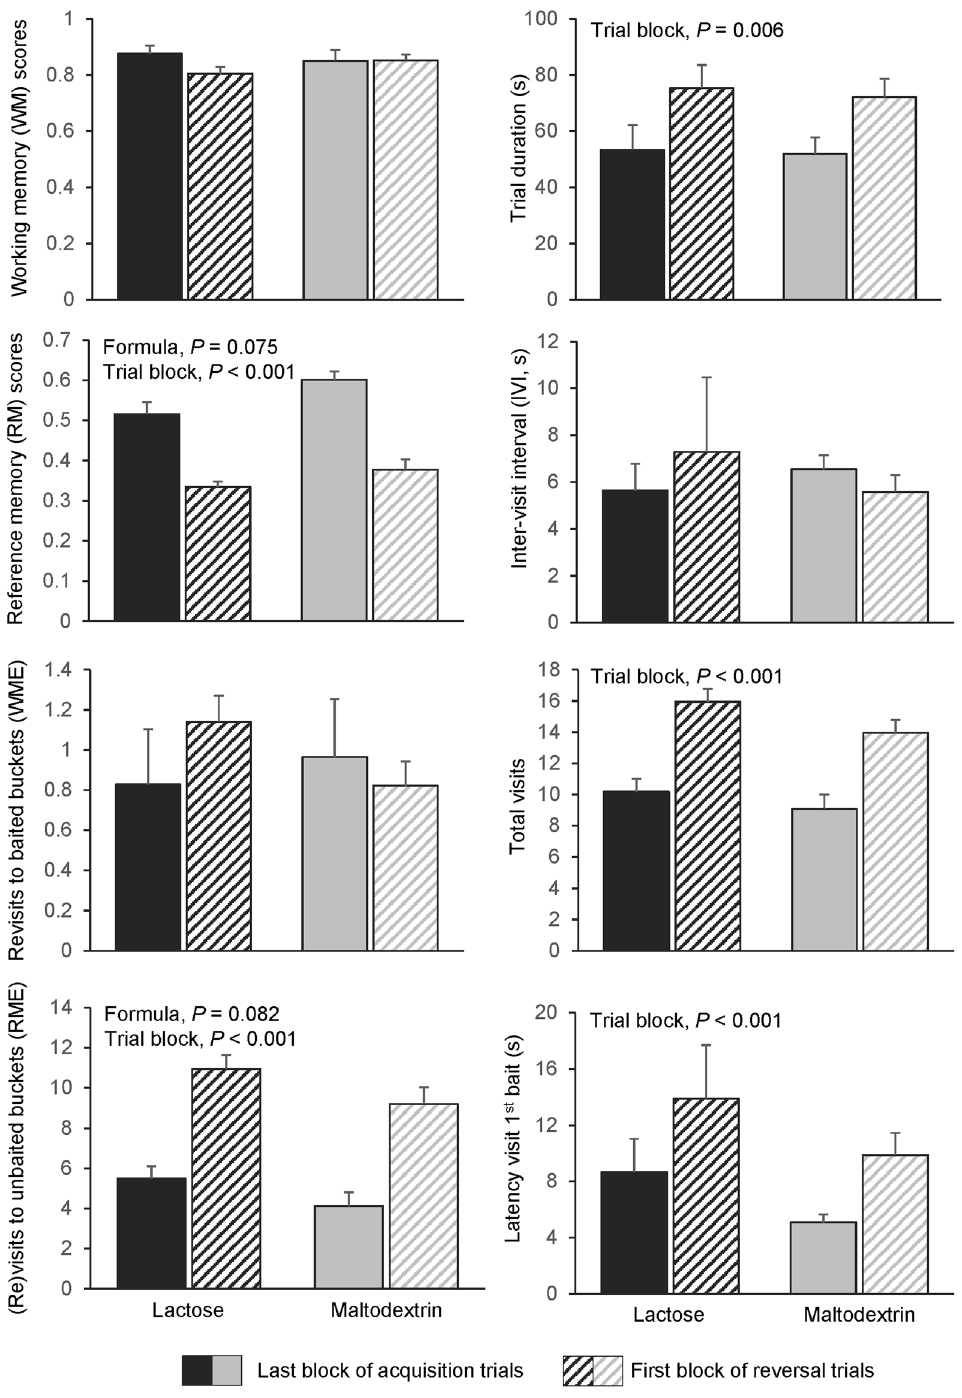
Figure 4. Changes of performance between the last block of 4 acquisition trials and the first block of 4 reversal trials in the spatial holeboard task, in piglets fed either a lactose-based formula or a maltodextrin-based formula from 1 to 9 weeks of age. During the reversal phase, the configuration of rewarded buckets was different than during the acquisition phase. The change of performance after the switch of configuration reflect the cognitive flexibility of the piglets. A block of trials represents the average of 4 consecutive trials. Data are expressed as means ± SEM and were analysed with a mixed